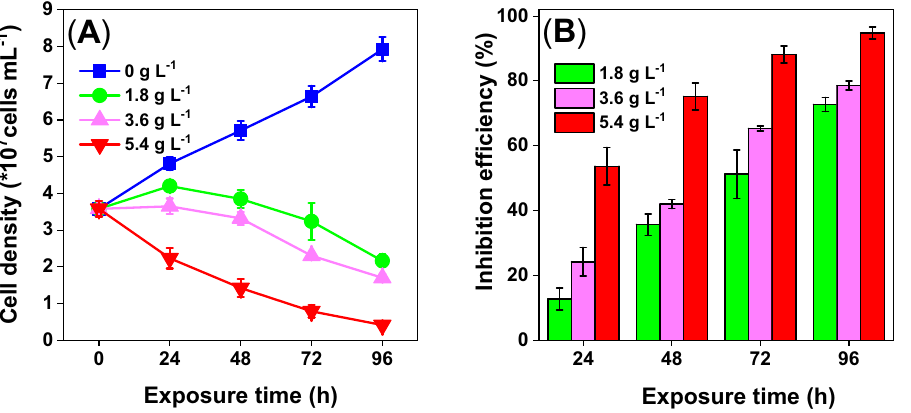
Figure 1. Growth curves ( A ) and algal growth inhibition efficiency ( B ) of the Dolichospermum flos-aquae after treatment with different aqueous extract of watermelon peel (WMPAE) concentrations. The data in the figures are shown as mean ± standard deviation (n =